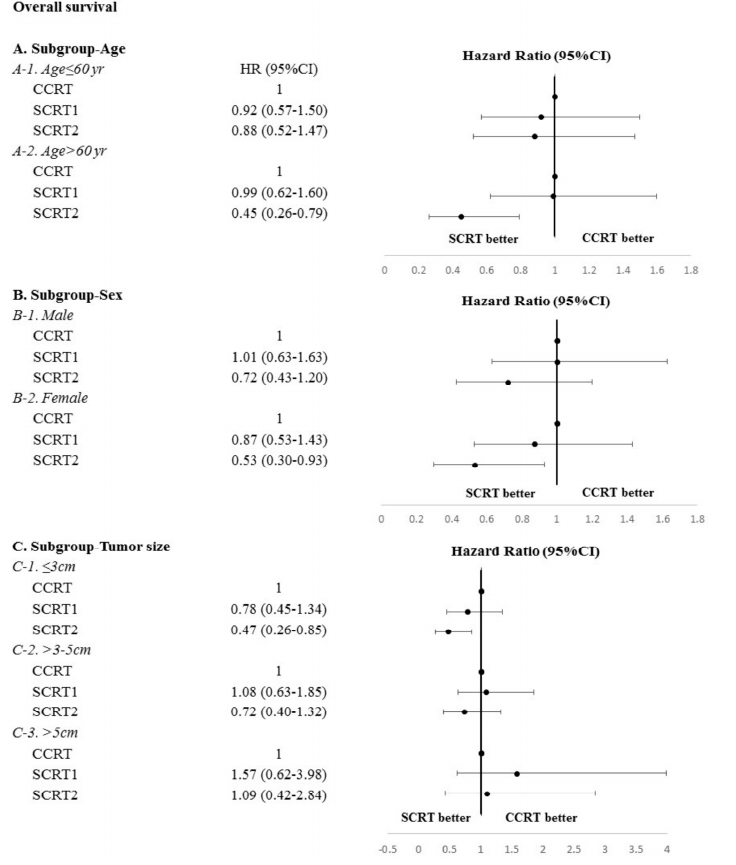
Figure 3. Forest plots of aHRs showing the effect of PORT timing on OS. The 95% CIs are also shown. Abbreviations: aHR: adjusted hazard ratio; CCRT: concurrent chemoradiation; OS: